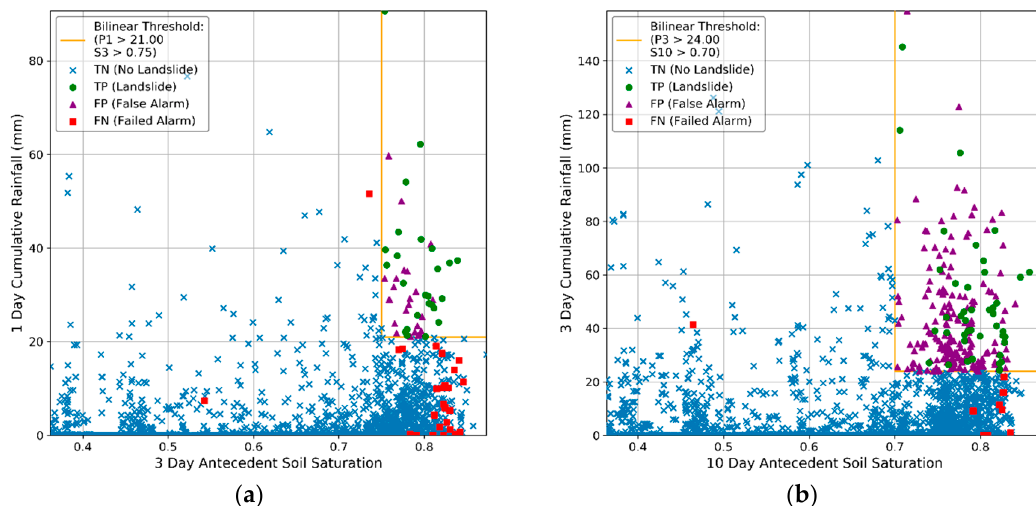
Figure 8. City of Portland hydro-meteorological threshold plots showing competing thresholds optimized with: ( a ) threat score; ( b ) optimal point statistic. Predicted landslide(s) are TP; false alarms are FP; no landslides are TN; missed landslide(s) are FN. Table 2. Selected iterations of different threshold formats for the City of Portland, illustrating improved performance for different skill metrics. Skill metric used for optimization is in bold text, optimal threshold equation and statistics for the two different optimizations are italicized .